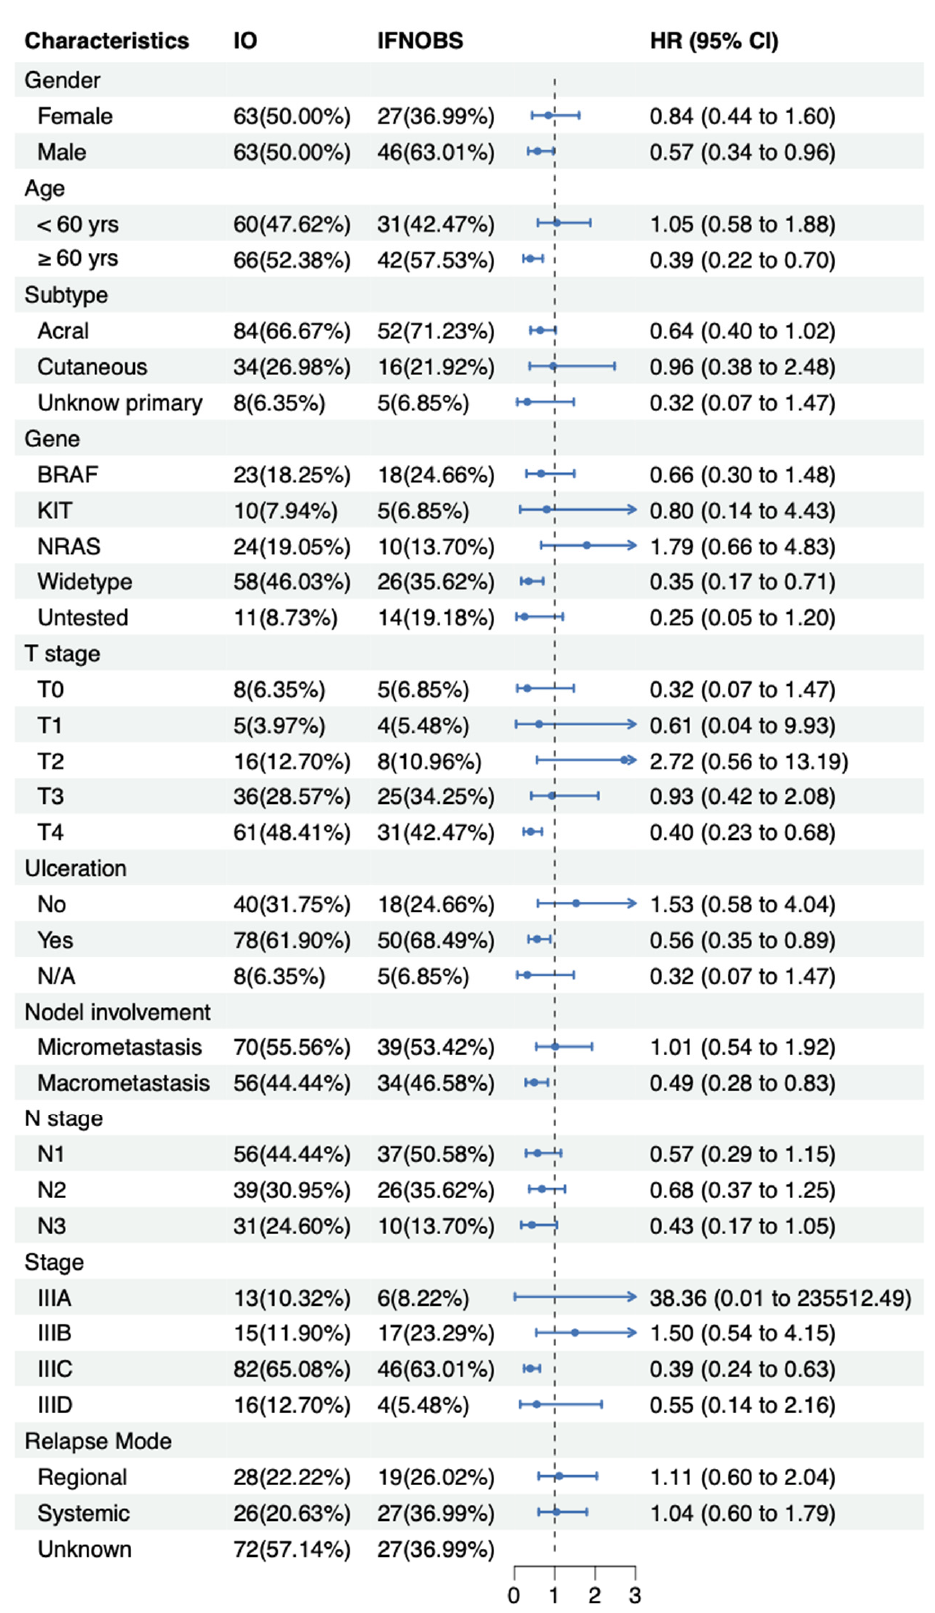
Figure 3. Forest plot of RFS according to subgroups. The hazard ratio of each subgroup is presented as green squares, while the 95% confidence intervals are presented as black lines.